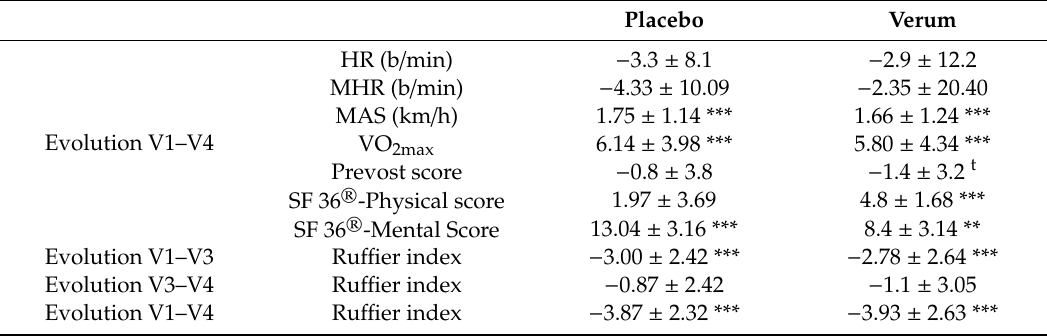
Table 1. Influence of the melon concentrate supplementation on the evolution of physical performance parameters, physical condition and SF 36 ® and Prevost scores. Intragroup comparison of Verum and and